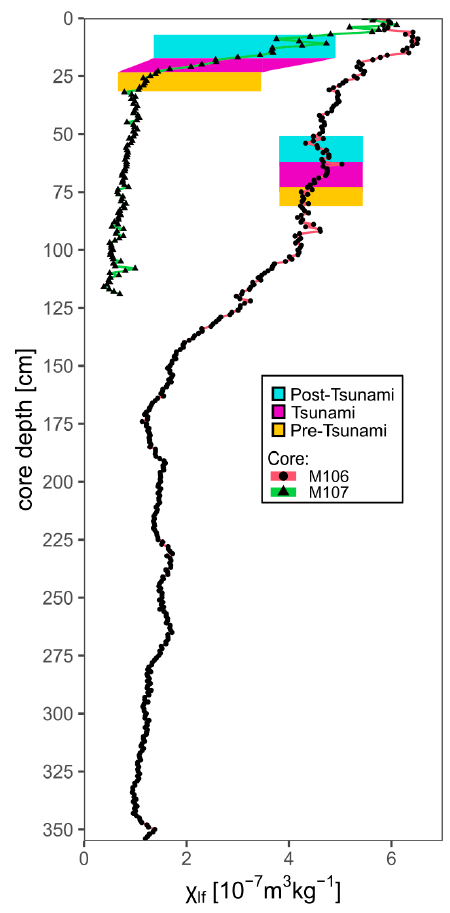
Figure 6. Mass normalized magnetic susceptibility χ LF (10 − 7 m 3 · kg − 1 ) values obtained for core M106 and M107. Horizontal bars represent the chronological layers: pre-tsunami (yellow), 1755 CE tsunami (violet), and post-tsunami (blue). Please note that this figure depicts all available samples of the cores. CT-scan data of core M106 show a decreasing radio-density trend (from lighter to darker colors)